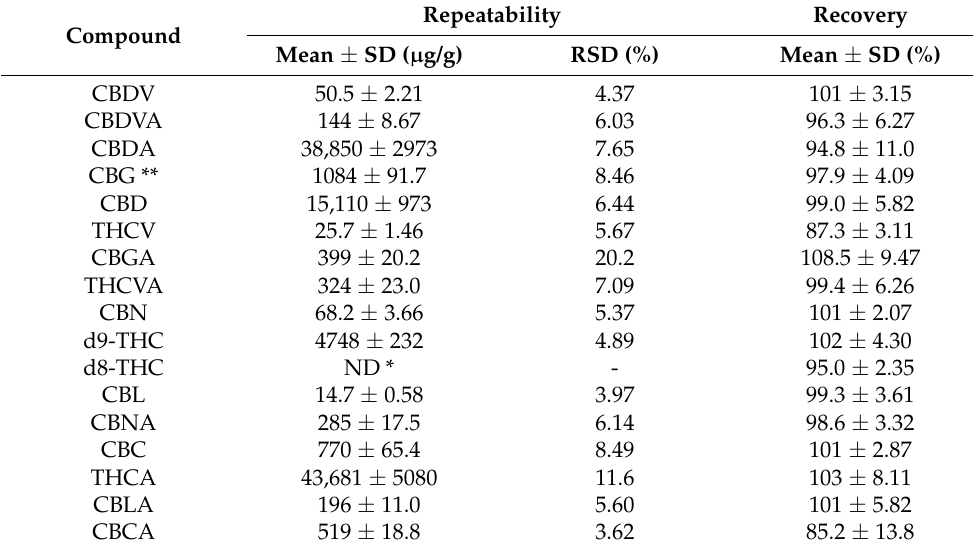
Table 3. Repeatability (as mean value with standard deviation in column 2 and as relative standard deviation in column 3), and recovery for each cannabinoid (n = 7) in the pooled inflorescence sample. Repeatability Compound